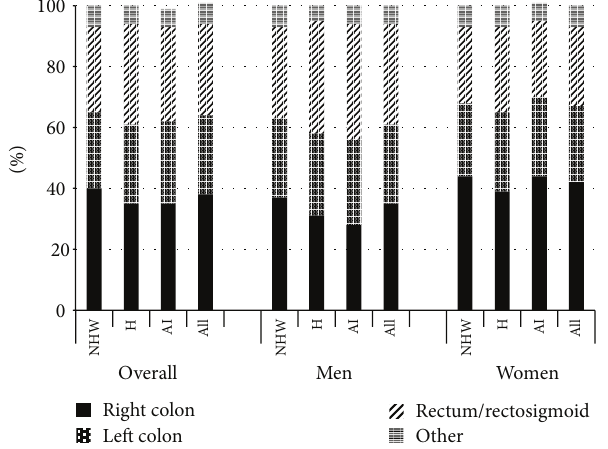
Figure 4: New Mexico colorectal cancer anatomic subsite distribu- tion by race/ethnicity and gender, 1995–2009. NHW: non-Hispanic white, H: Hispanic, and AI: American Indian. Columns do not all sum to 100% due to